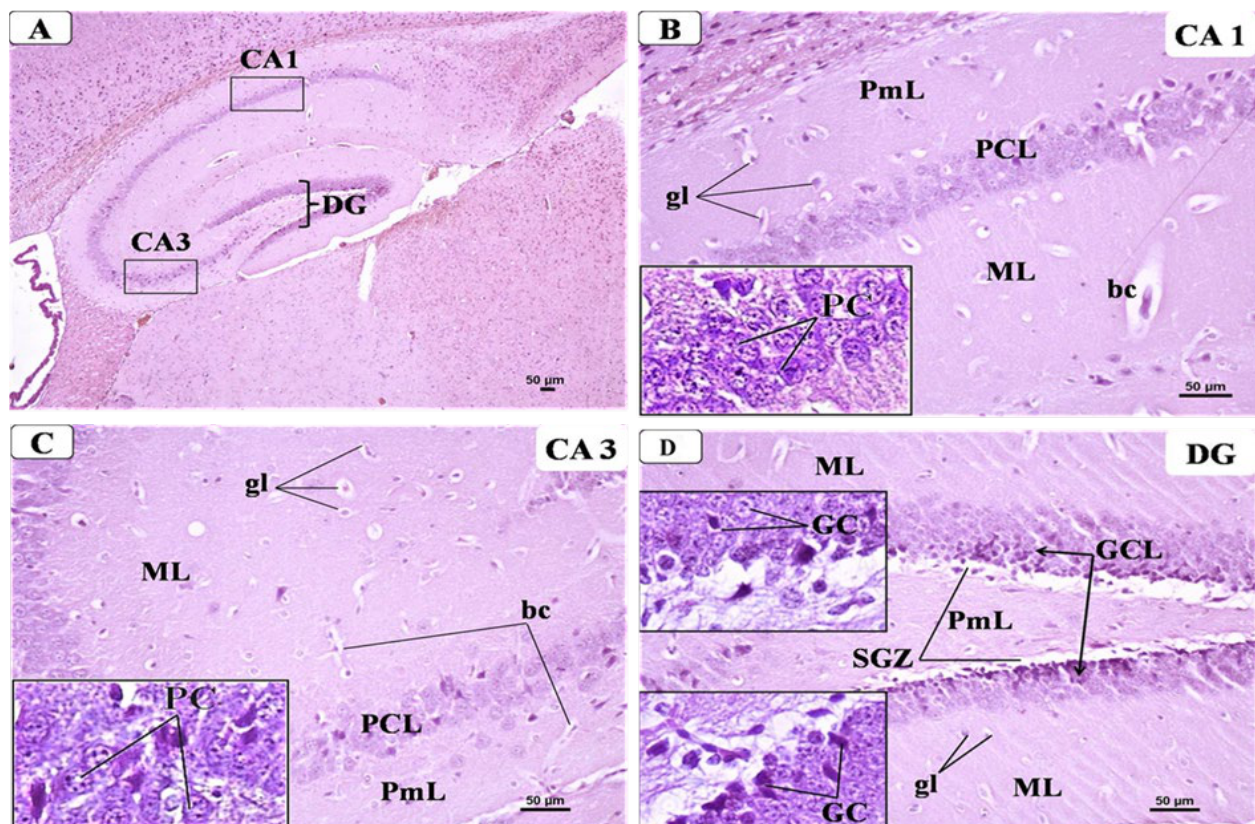
Figure 9. Representative photomicrographs of H&E-stained sections of the hippocampus from CPZ + BCA A-treated group: ( A ) C-shaped Cornu Ammonis with its CA1 and CA3 areas and dentate gyrus (DG). (H&E × 40.) ( B ) CA1 was formed of three layers: ML, PCL, and PmL. There was improvement of the histological picture with the preservation of most of the pyramidal cells (PC) as compared with the CPZ group but few cells showing condensed nuclei (H&E × 200, Inset × 400). ( C ) CA3 was formed of three layers: ML, PCL, and PmL. Many pyramidal cells (PC) looked normal with vesicular nuclei (H&E × 200, Inset × 400). ( D ) DG showing preservation of many granular cells (GC) appeared nearly similar to the control (insets). Both ML and PmL layers contained normally appearing glial cells (gl) and blood capillaries (bc). SGZ appeared nearly normal.